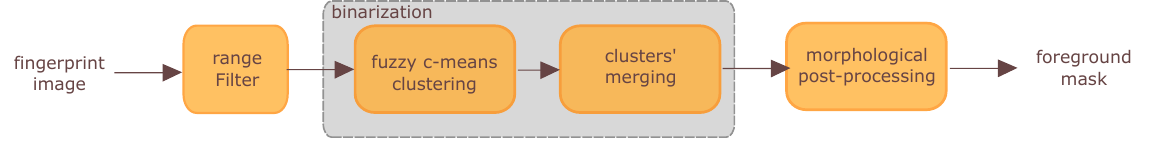
Figure 5. Main steps of the segmentation method (adapted from